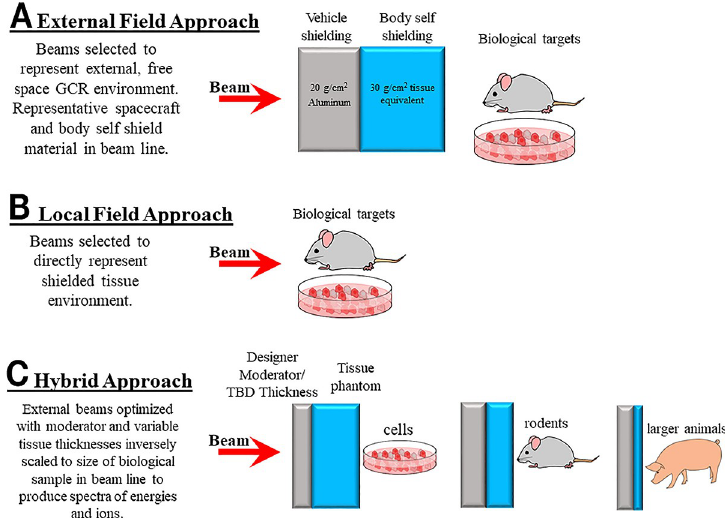
Fig 5. Three basic strategies for beam selection. (A) Beam selection is representative of the external, free-space GCR spectrum and is approximated by discrete ion and energy beams delivered onto a shielding and tissue equivalent material placed within the beam line, in front of the biological target. (B) Beam selection is representative of the shielded tissue spectrum found in space (e.g., average tissue flux behind vehicle shielding) and is approximated by discrete ion and energy beams delivered directly onto the biological target. (C) Beam selection is representative of energies less than free space with thinner amounts of vehicle shielding and variable thicknesses of tissue equivalent materials to represent the differences in body self-shielding between the physical sizes of species. GCR, galactic cosmic radiation.